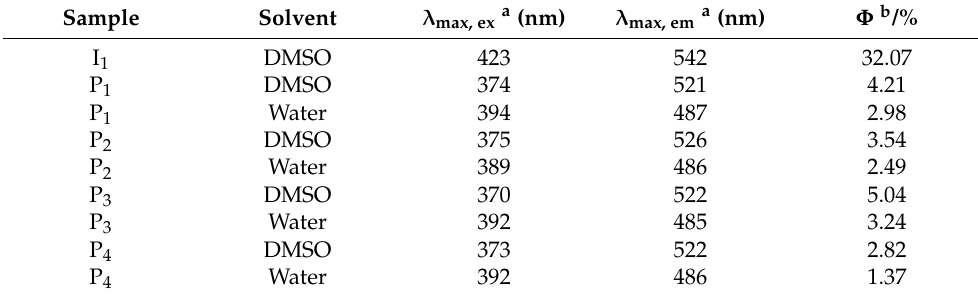
Table 4. Summary of the photophysical properties of the PFONPN backbone, I1 in DMSO, and four water-soluble bottlebrush copolymers, P 1 –P 4 , in water and